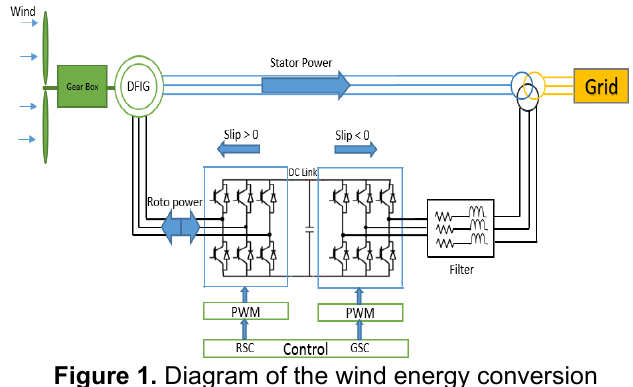
Figure 1. Diagram of the wind energy conversion